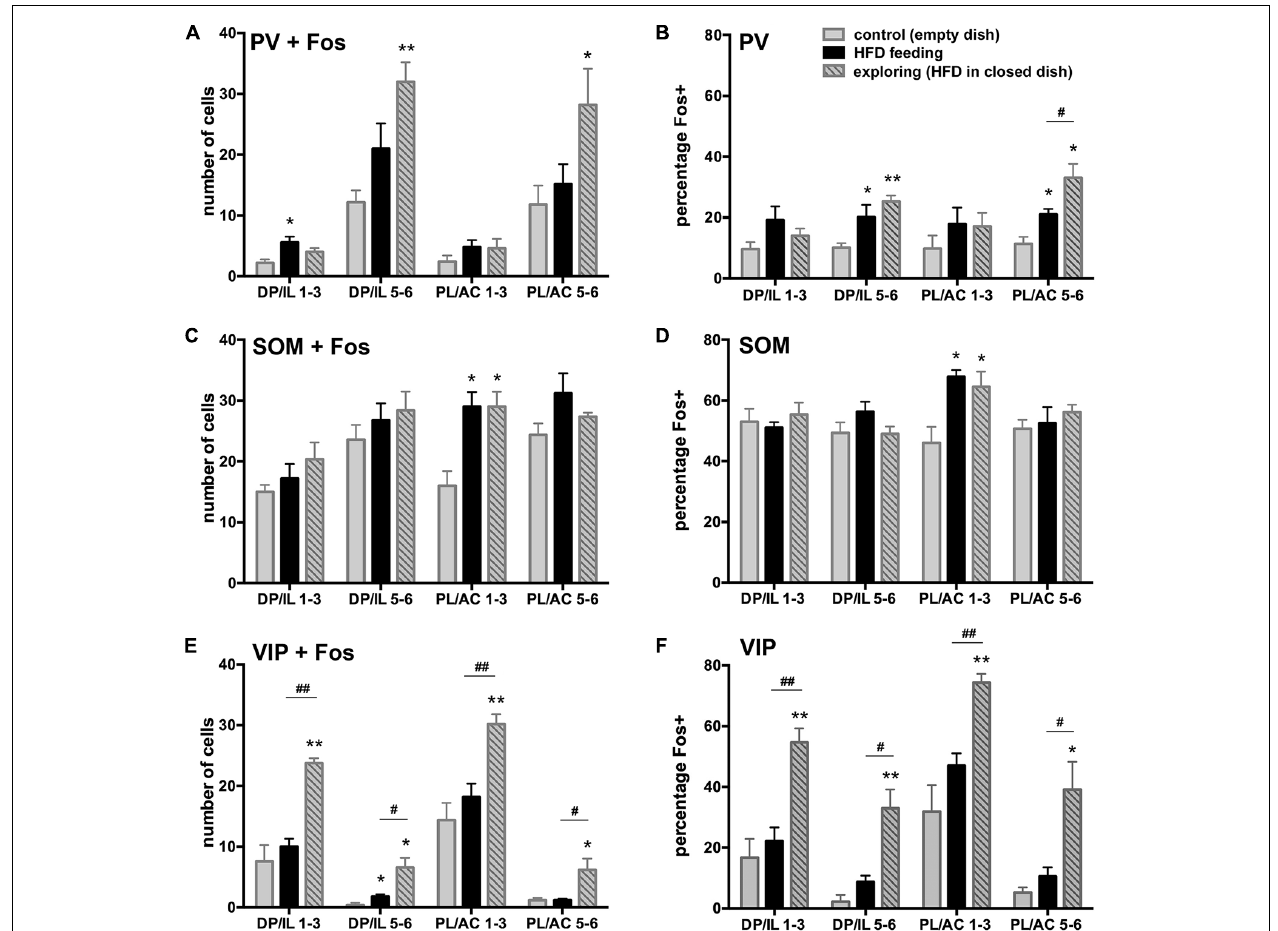
SOM-labeled neurons in layers 1–3 of the PL/AC showed comparable increases in Fos-ir among the HFD feeding and exploring groups, but no differences between groups were apparent in the other parts of the mPFC, where about half of all SOM-labeled cells were Fos-positive. E,F : Among the VIP neurons, a robust increase in Fos-ir occurred in the food-driven exploration group, whereas HFD feeding led to a small but insignificant rise. * p < 0.05, ** p < 0.005, differences with respect to the control group; # p < 0.05, ## p < 0.005, differences between feeding and exploring